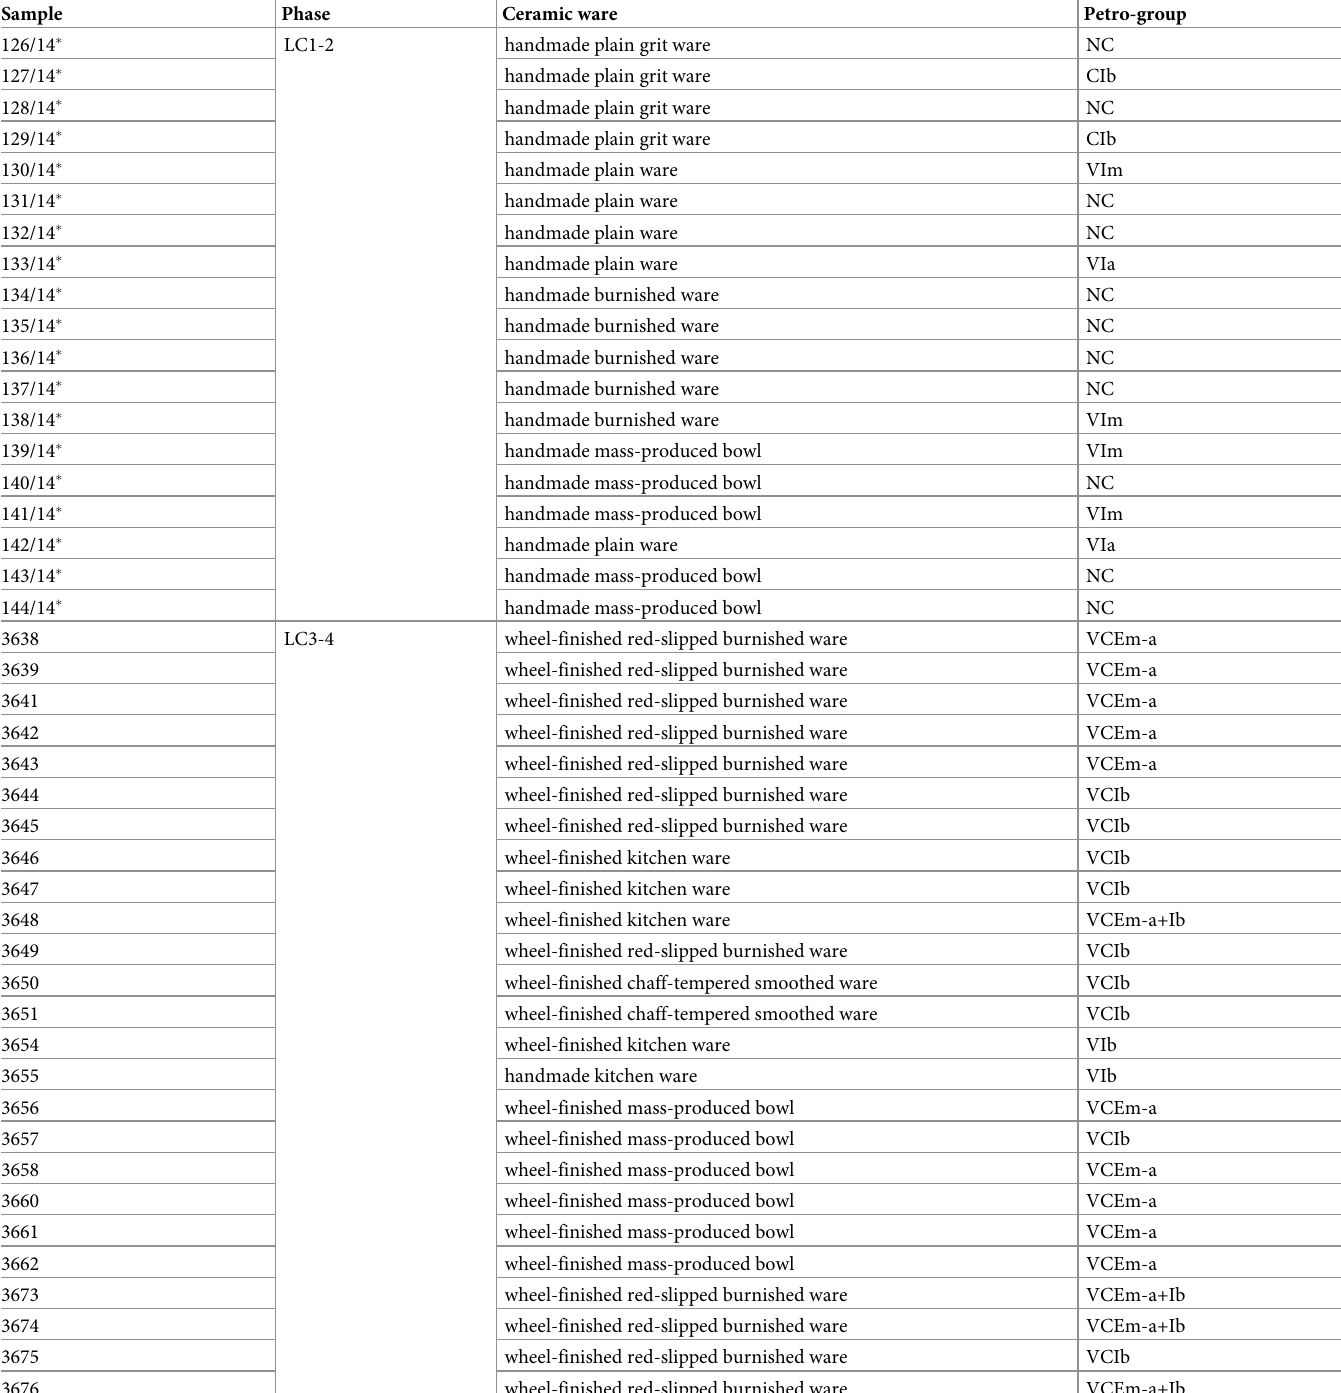
Table 2. List of the samples analyzed petrographically and related petrographic groups.